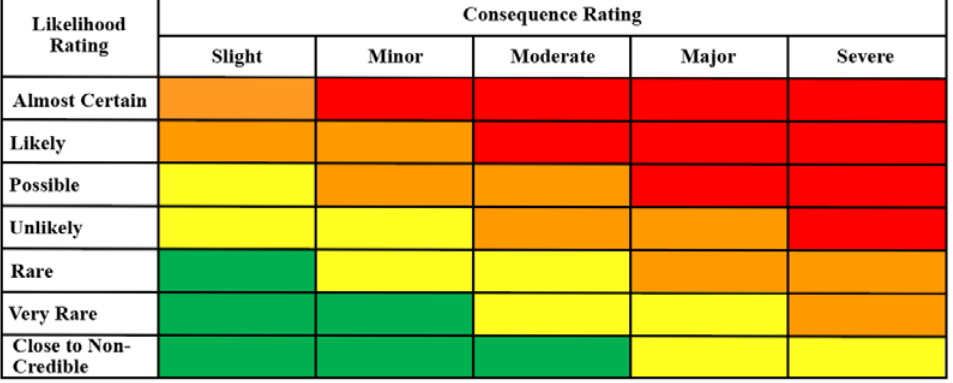
Figure A2. Initial colour-coded risk matrix with consideration of iso-contours.